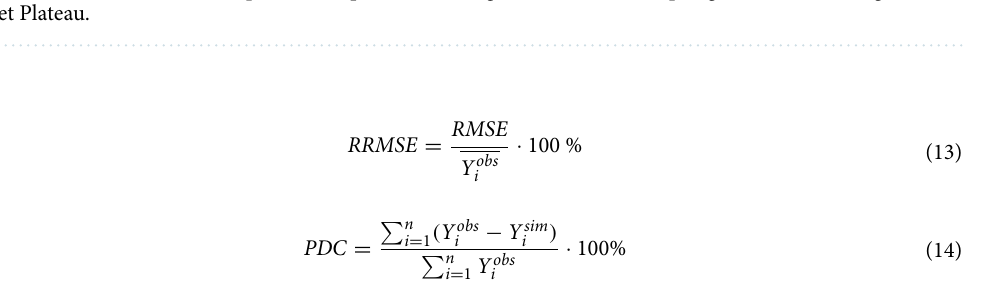
Table 3. The accumulated temperature required for each growth duration of spring wheat in the Qinghai- Tibet Plateau.